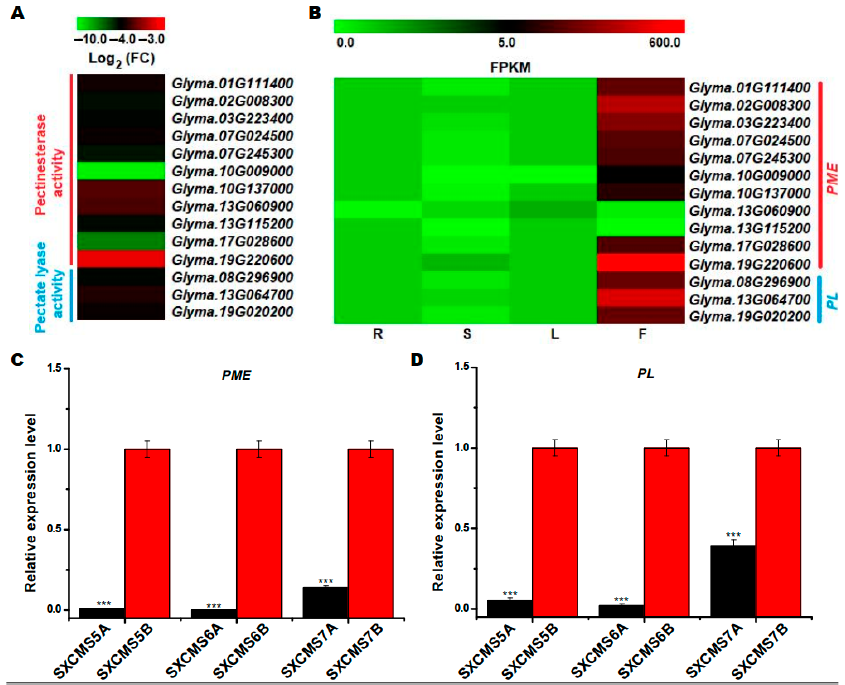
Figure 5. Analysis of DEGs related to pollen wall development between soybean CMS lines and their maintainer lines. ( A ) Heat map of the DEGs related to pollen wall development between SXCMS5A and SXCMS5B. The heat map was created using MeV 4.9 software. Log 2 (FC) values were obtained from RNA-seq data in this study. ( B ) Heat map of the DEGs related to pollen wall development in four different tissues. The color scale represented the relative transcript abundance of the DEGs in four soybean tissues. The heat map was created using MeV 4.9 software. Fragments per kilobase of transcript per million mapped reads (FPKM) values were obtained from RNA-seq data in Phytozome v12.0. R, root; S, stem; L, leaf; F, flower. ( C , D ) Relative expression level of GmPME ( Glyma.02G008300 ) and GmPL ( Glyma.13G064700 ) between soybean CMS lines and their maintainer lines by qRT-PCR analysis. PME, Pectin methylesterase; PL, pectate lyase. Asterisk indicated statistical significance: ***, p < 0.001.